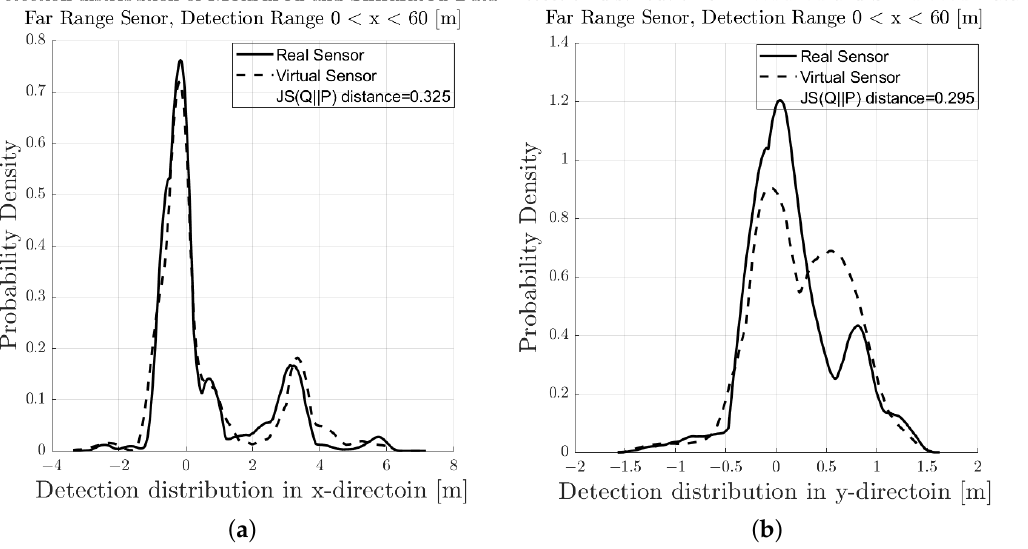
Figure 8. Visual comparison and evaluation of the PDF of the deviation of the measured and simulated radar point clouds with respect to the reference point in the near-range detection sector.